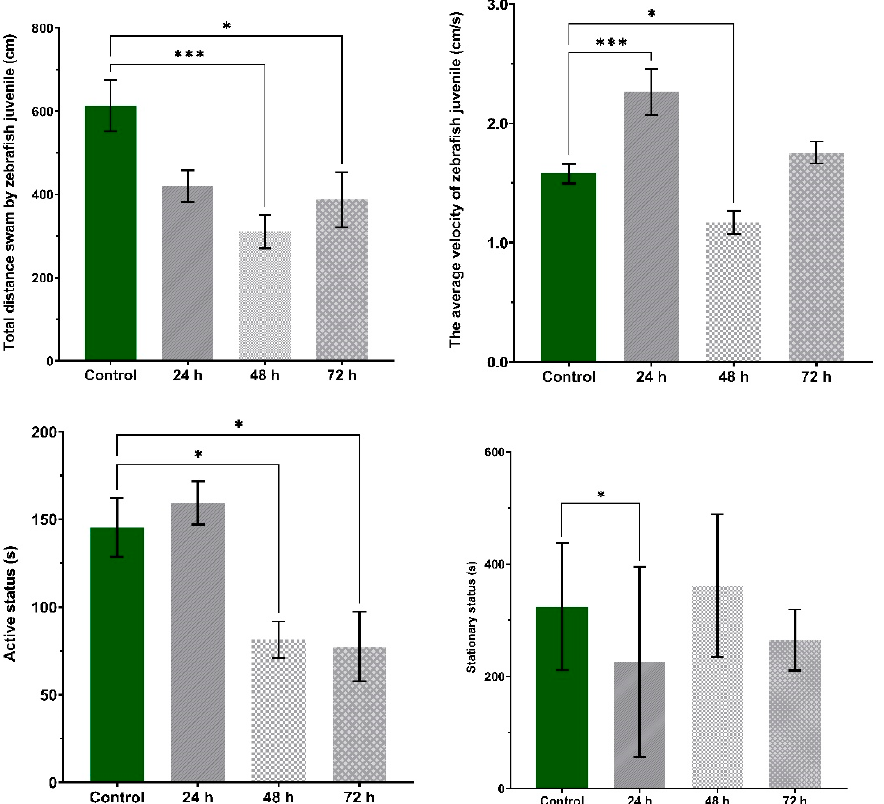
Figure 8. The main parameters of locomotor activity during the social interaction test. Group 1, control ( n = 30); Group 2, group exposed for 24 h to VPA ( n = 24); Group 3, group exposed for 48 h to VPA ( n = 24); and Group 4, group exposed for 72 h to VPA ( n = 22). Active status parameter represents the time spent moving by fish being active and stationary status the time spent in inactivity. The data is represented as average ± SEM. Anova and Tukey post-hoc tests, p < 0.05 was considered to be significant. The experimental groups were compared to control group, where * p < 0.05 and *** p < 0.001.